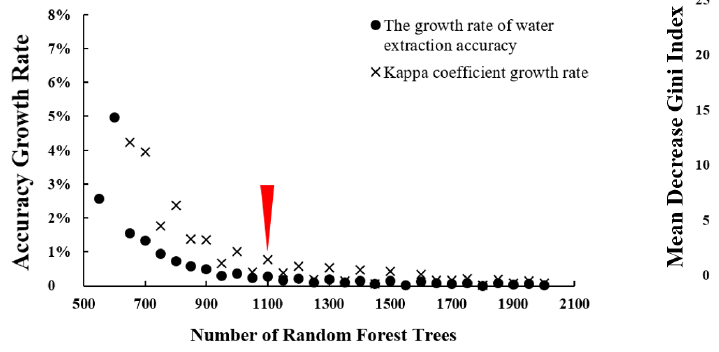
( b ) Figure 8. Effect of the river surface denoise. ( a ) Schematic representation of preliminary waterbodies extraction results. River blanking and the noise were shown. ( b ) River network buffer zone constraints and postprocessing results . Figure 9a shows that the RF-ANN method can completely extract the order 4 rivers and most of the order 3 rivers of DNET. The comparisons between RWC river centrelines and ARWE centrelines are shown in Figure 9b.